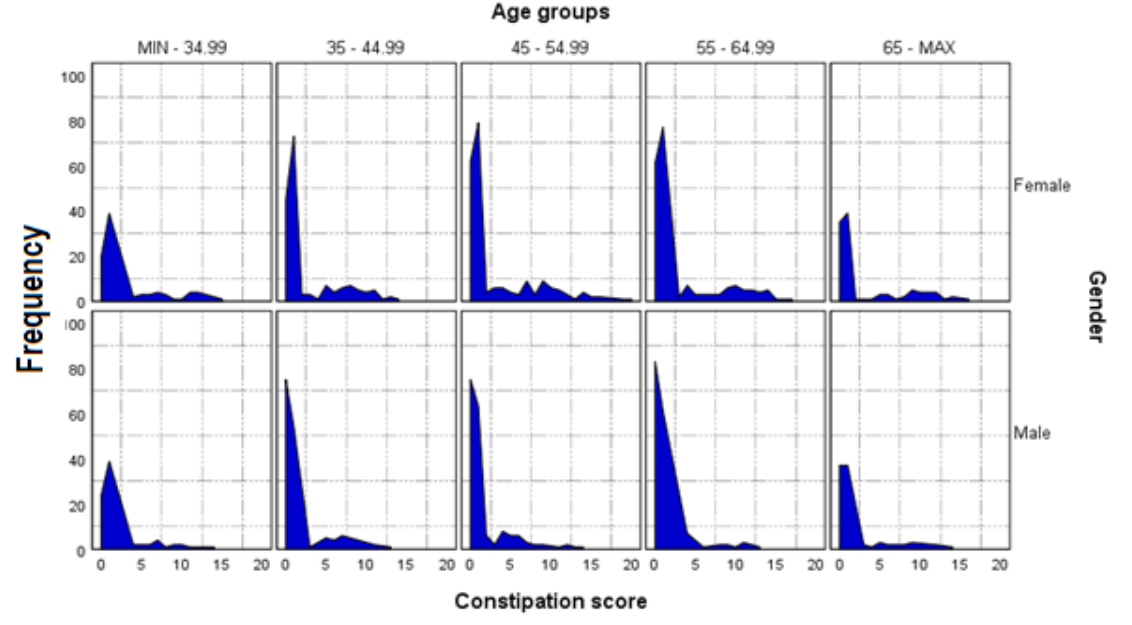
Figure 3. Frequency chart of constipation score by age groups in men and women. Zero is the lowest possible score (no constipation); 30 represents severe constipation. Score according to [34]. The medians and interquartile range values of daily intake of food groups (Table 3) and nutrients (Table 4) are presented based on gender and constipation score categories.